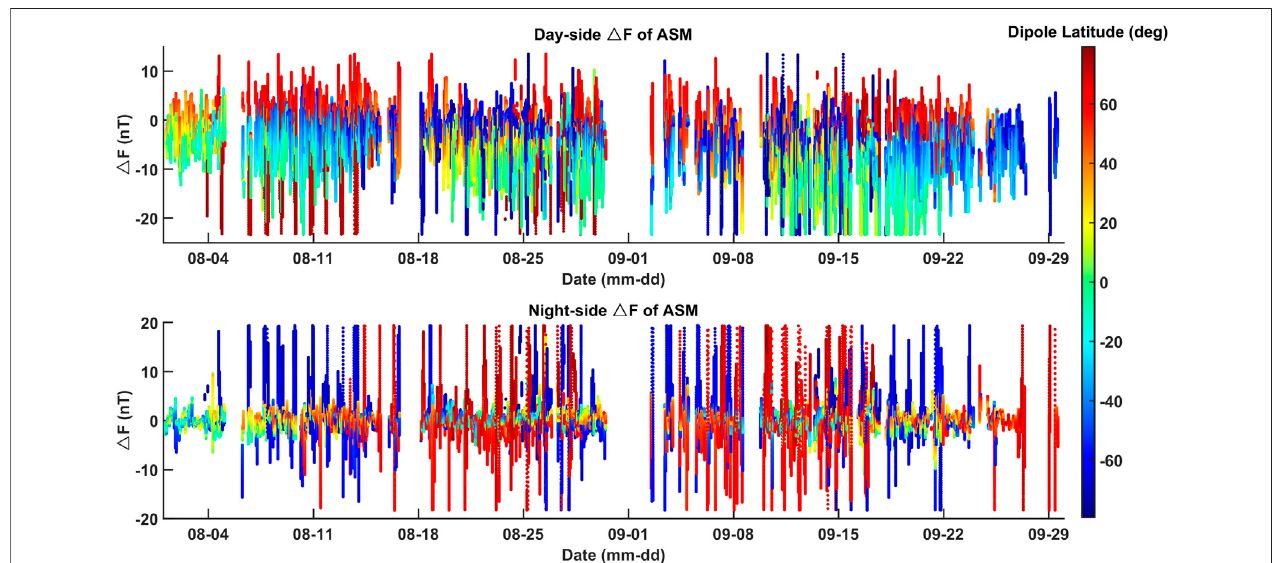
FIGURE 4 | Δ F of the ASM from 31 July 2019 to 30 September 2019 (different colors represent the dipole latitudes of data